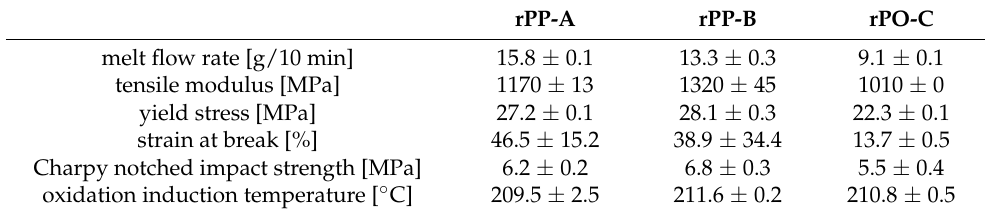
Table 2. Properties of the used